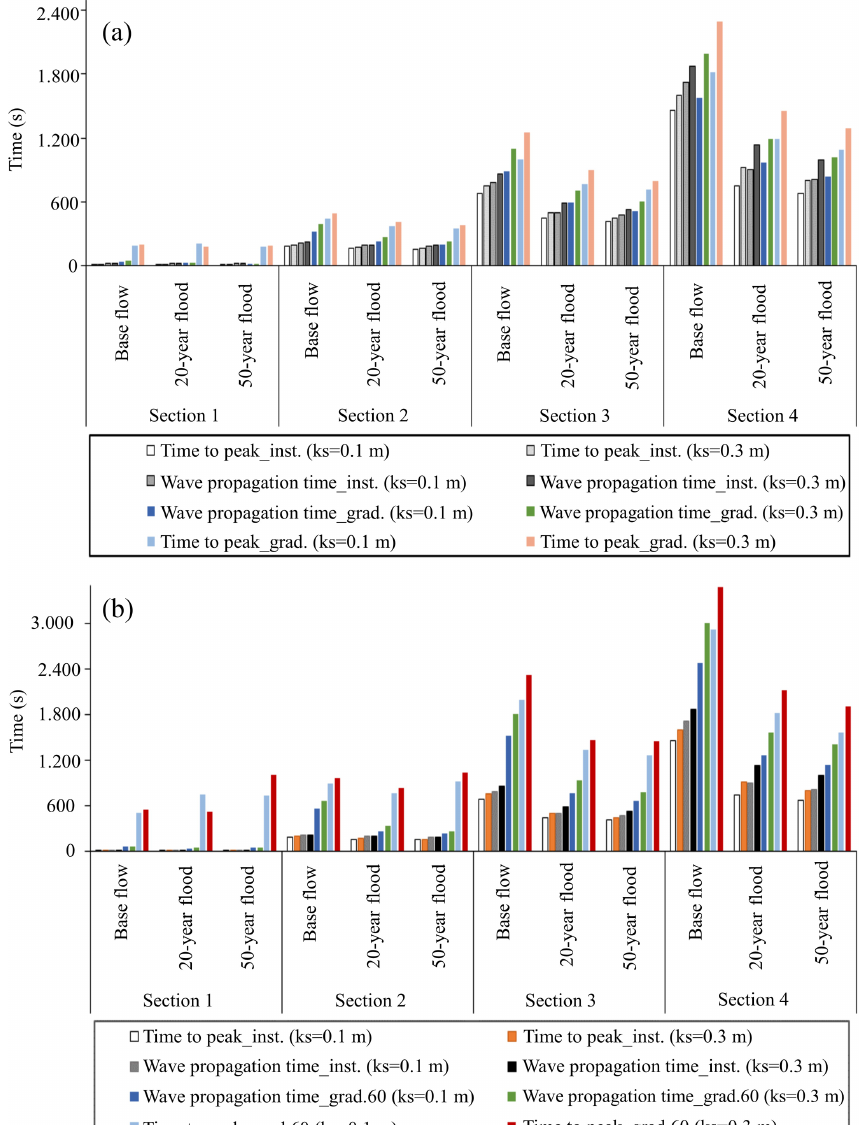
Figure 14. (a) Computed wave propagation time and time to peak in sections 1 to 4, for various pre-failure flow conditions (base flow, 20- and 50-year flood) and for two different roughness heights ( k s = 0.1m and k s = 0.3 m). The gradual failure time is 10min. (b) Computed wave propagation time and time to peak in sections 1 to 4, for various pre-failure flow conditions (base flow, 20- and 50-year flood) and for two different roughness heights ( k s = 0.1m and k s = 0.3m). The gradual failure time is